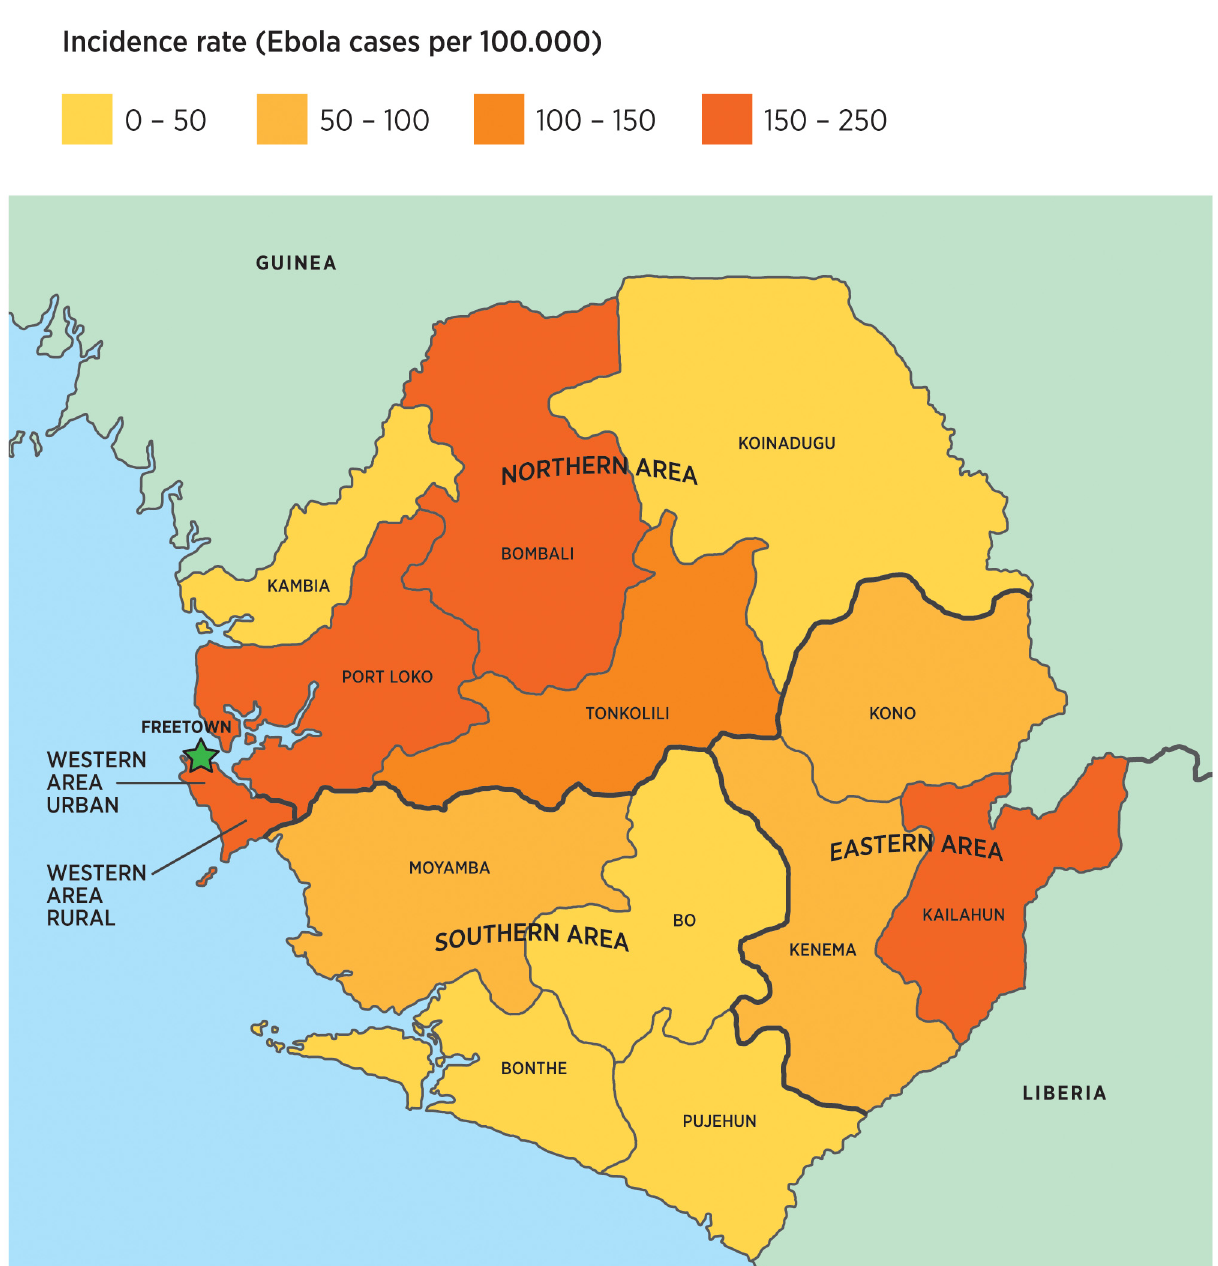
Fig 1. Burden of EVD in Sierra Leone EVD incidence rate per 100 000 inhabitants shown per district and